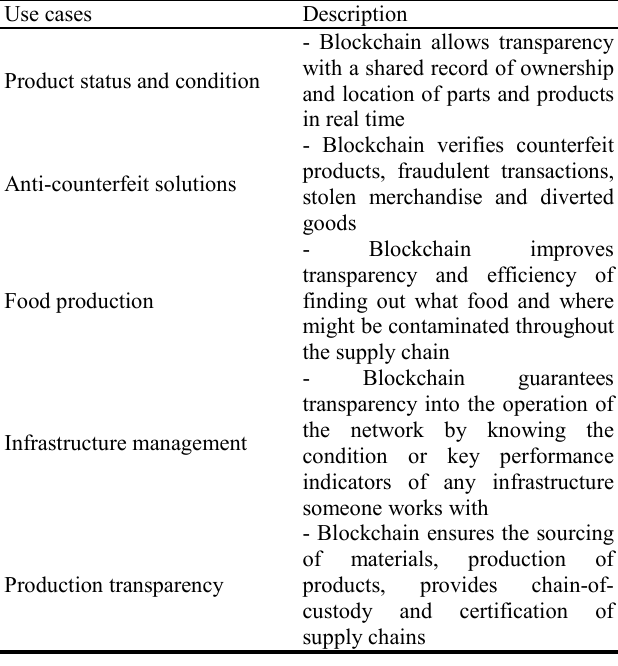
Figure 4. Storing content in IPFS